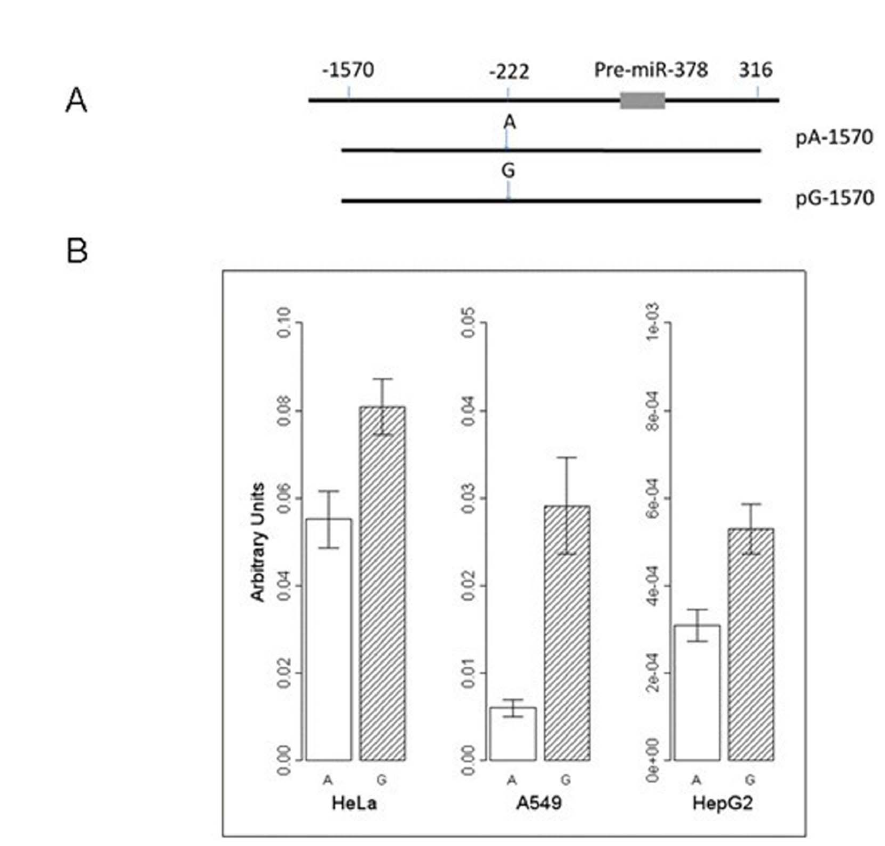
Figure 1. Promoter activity with different constructs containing different alleles of rs1076064 (A . G). (A) Schematic representation of the pre-miR-378 flanking region and reporter gene constructs. (B) Luciferase expression of constructs containing rs1076064 A or G allele in HeLa, A549, and HepG2 cells. All constructs were cotransfected with pRL-SV40 to standardize the transfection efficiency. Luciferase levels of the constructs, pGL3-Promoter and pRL-SV40 plasmids were determined in triplicate. Fold increase was measured by defining the activity of the empty pGL3- Promoter vector as 1. Columns, means from two independent experiments, each in triplicate; bars, SE.